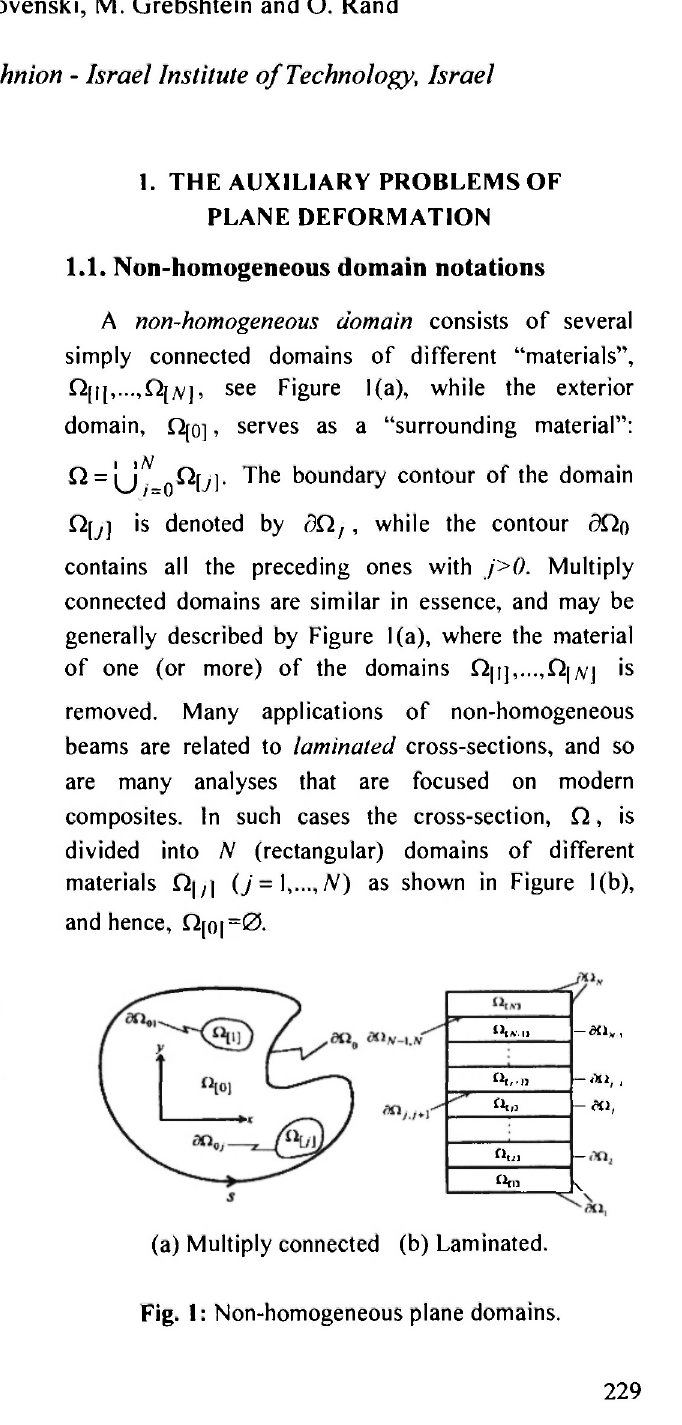
Fig. 1: Non-homogeneous plane